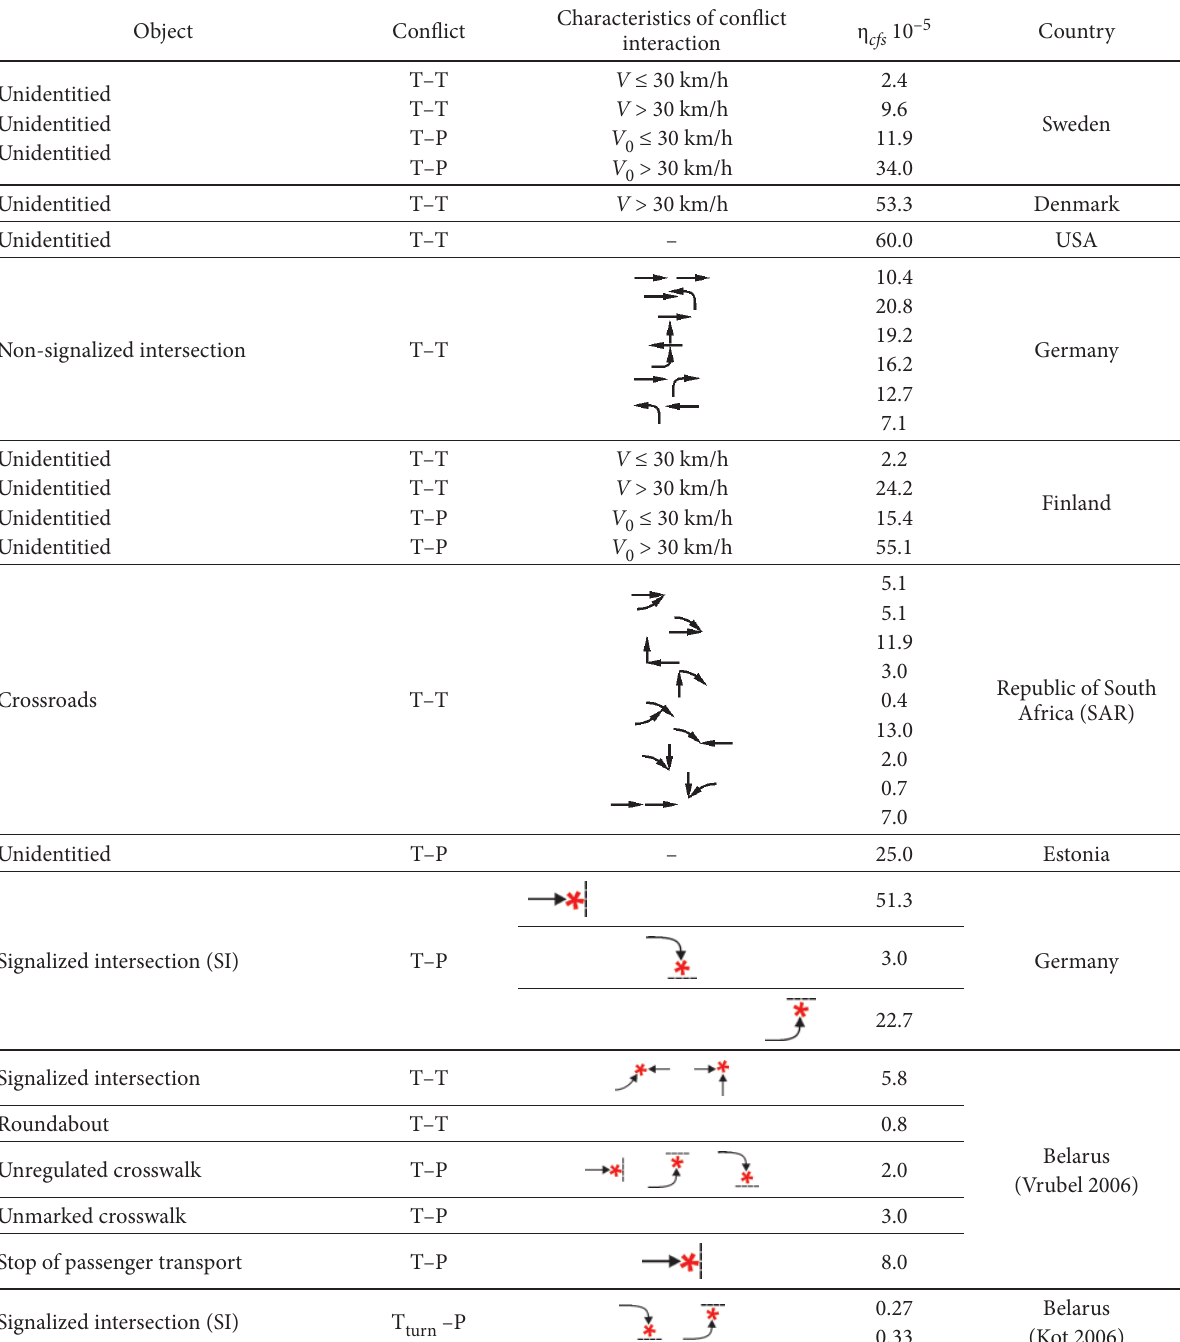
Table 1. The value of the reduction coefficient η cfs (Kot 2005, 2006; Laureshyn 2010; Vrubel et al . 2006) Object Conflict